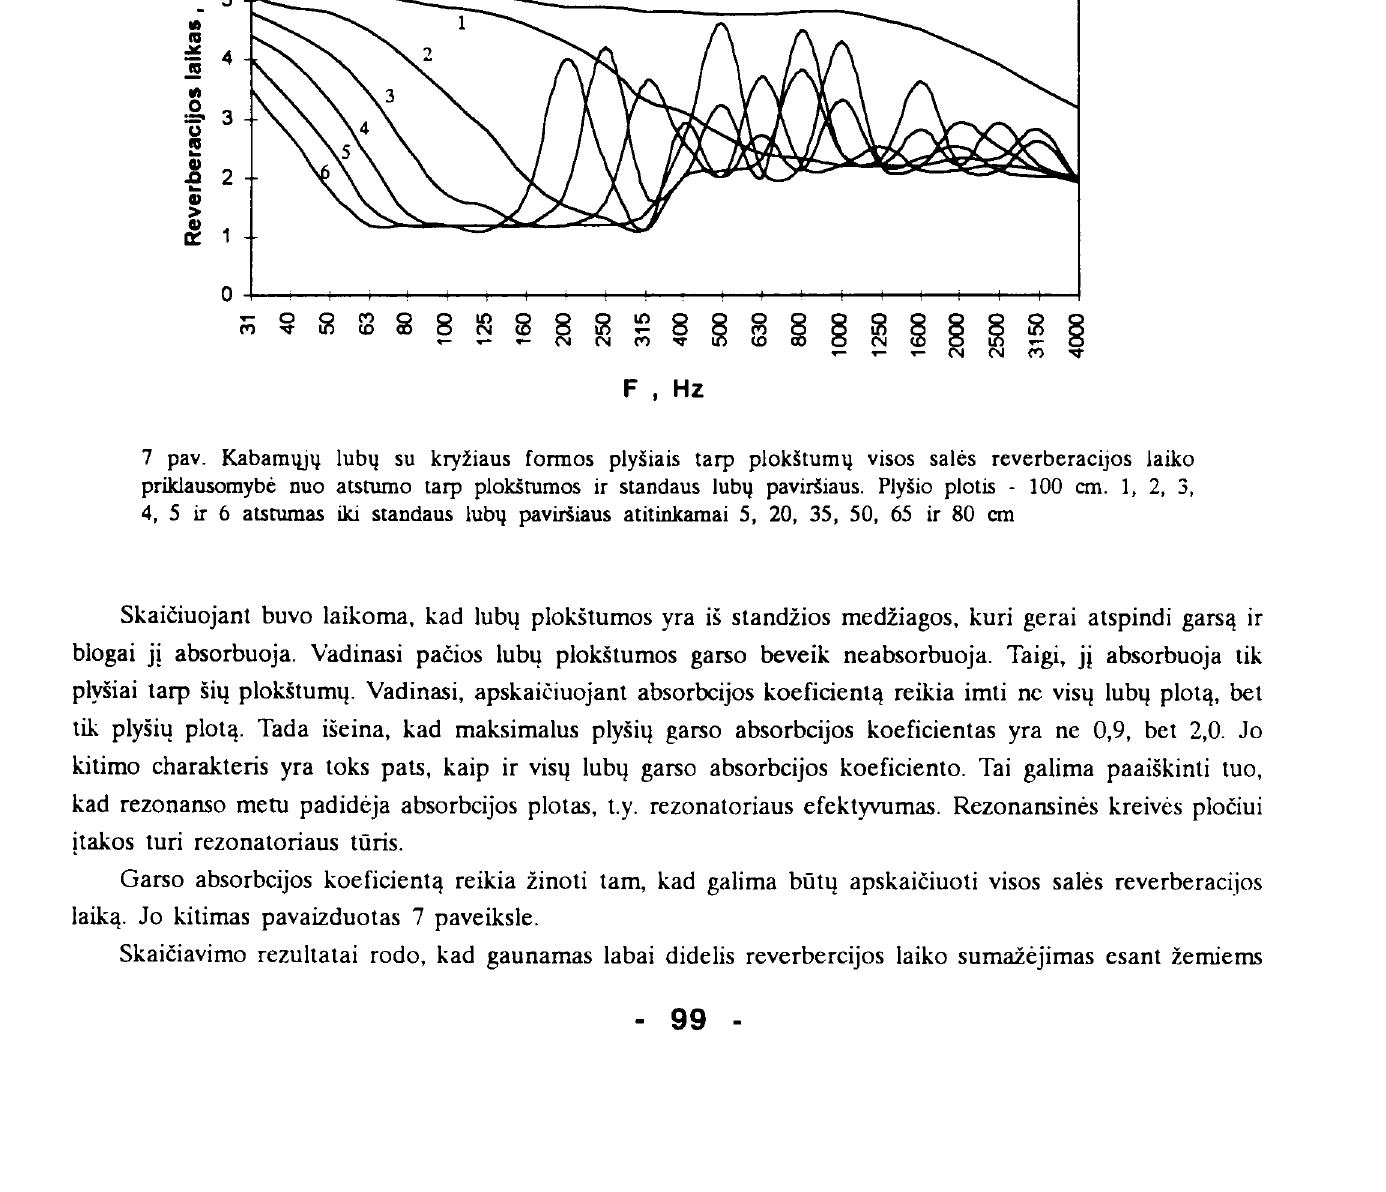
priklausomybe Duo atstumo tarp plokStumos ir standaus lubq pavir5iaus. Plysio plotis - 100 em. 1, 2, 3, 4, 5 ir 6 atstumas iki staDdaus lubq paviriiaus atitinkamai 5, 20, 35, 50, 65 ir 80 em